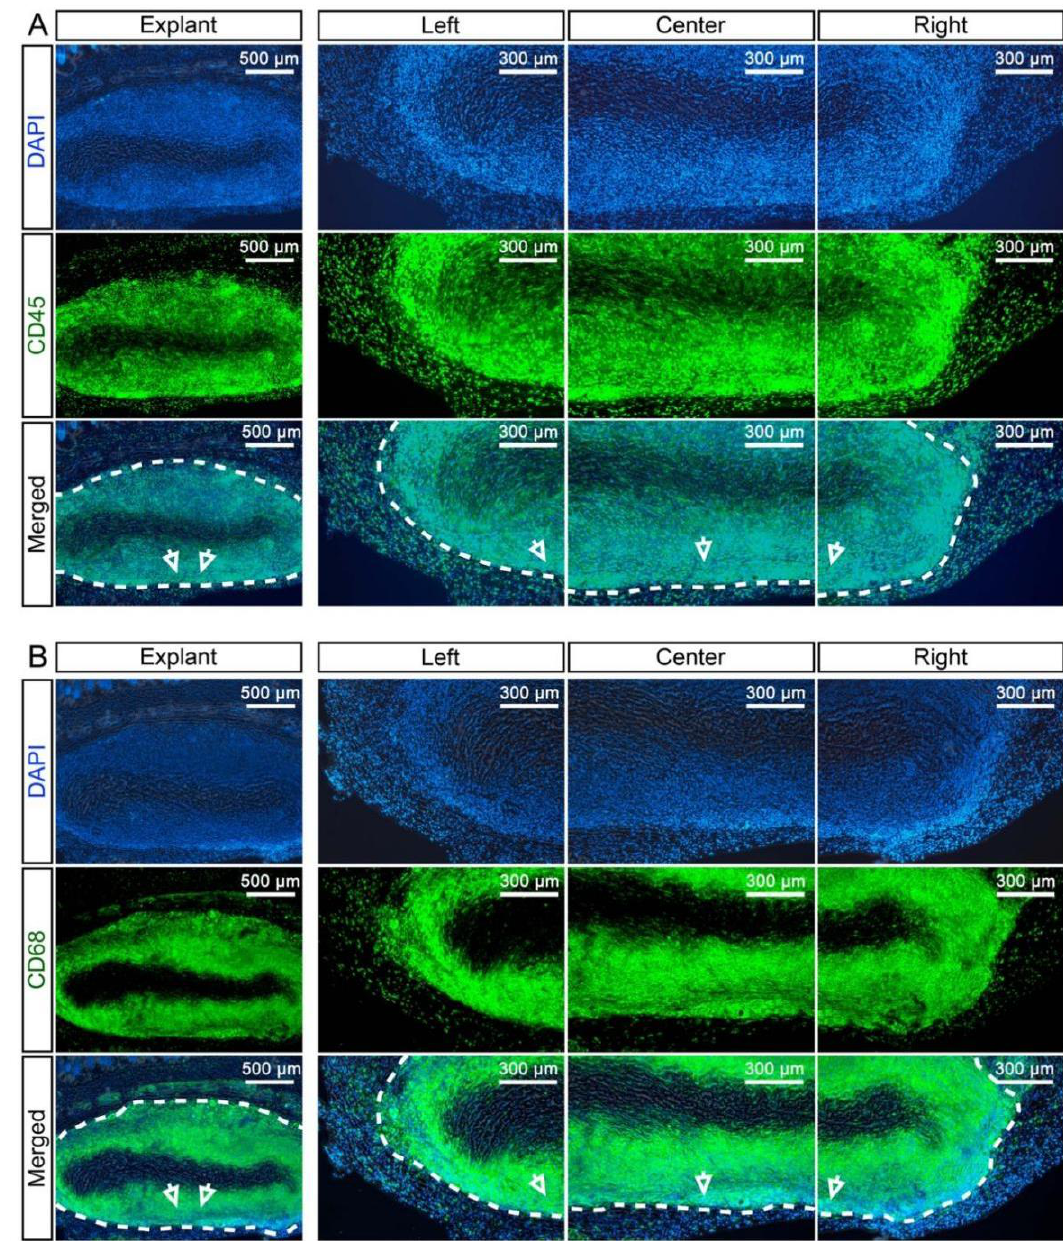
Figure 5. Identification of the cell type invading the dUA upon in vivo implantation. Representative images from fluorescent staining for the ( A ) well known haematopoietic marker (except for erythrocytes) CD45 (green) and ( B ) the macrophage marker CD68 (green) in dUA explants ( n = 12). Nuclei are stained by DAPI (blue). Antibody controls did not reveal any non-specific staining (data not shown). The arrows mark the same location of the dUA scaffold in different magnifications. Dotted lines mark the edge of the dUA